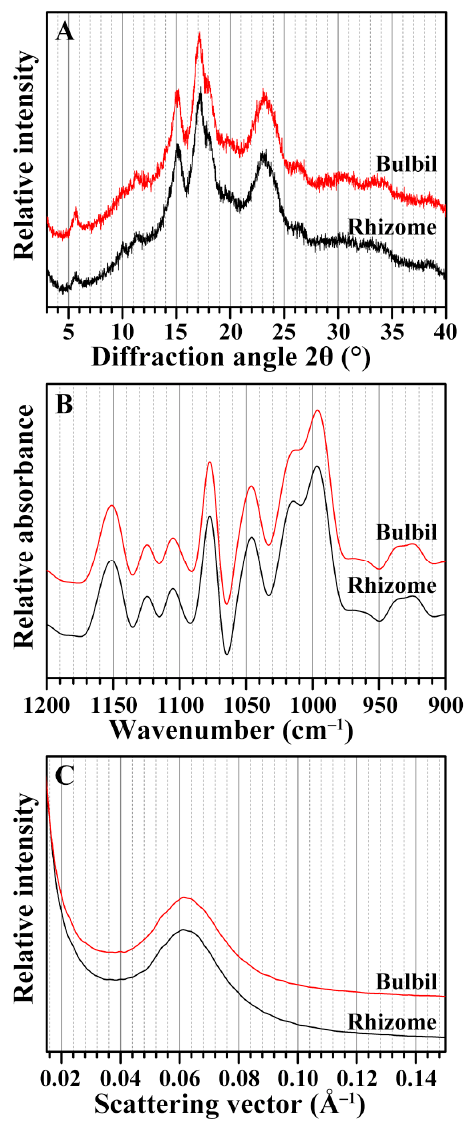
Figure 2. XRD pattern ( A ); FTIR spectrum ( B ); and SAXS profile ( C ) of starches from the rhizome and the bulbil of Chinese yam. Table 3. Relative crystallinity, IR ratio, and lamellar structure parameters of starches a .